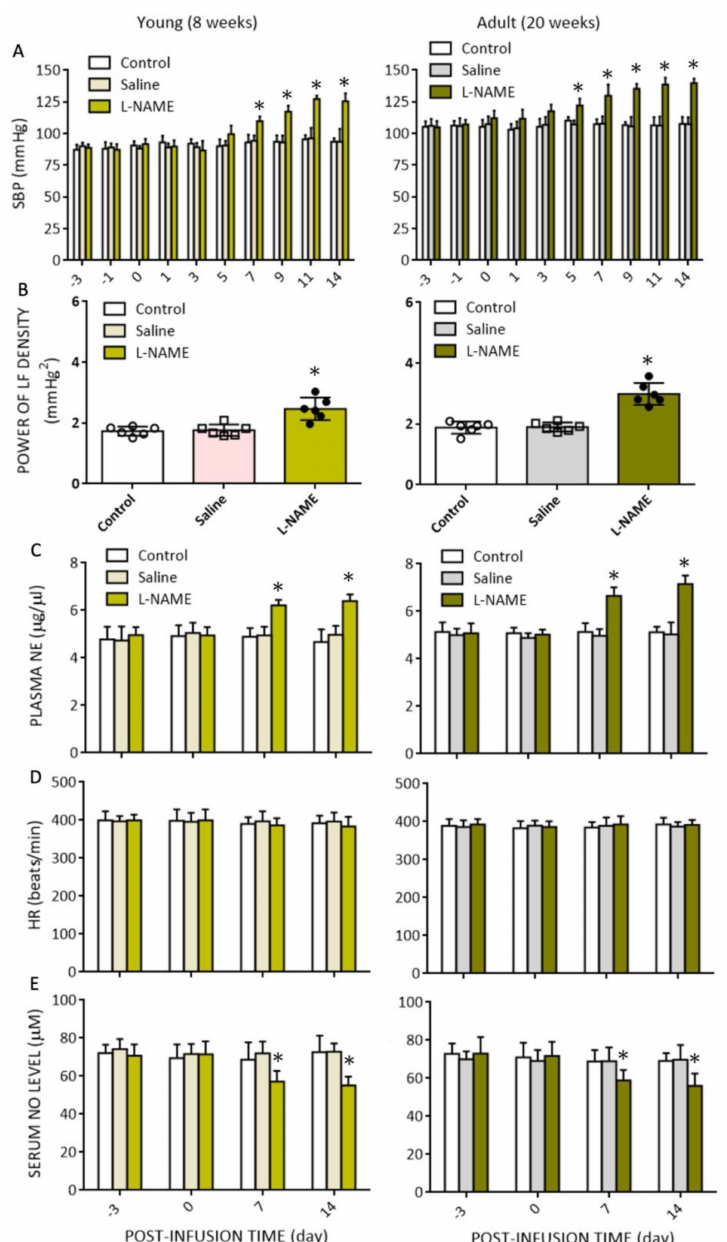
Figure 2. Temporal changes in hemodynamic parameters and serum NO (nitrite and nitrate) levels in response to intraperitoneal infusion of L -NAME (10 mg/kg/day) for 14 days. Changes in ( A ) systolic blood pressure (SBP); ( B ) power density of low-frequency (LF) component of SBP signal; ( C ) plasma norepinephrine (NE) levels; ( D ) heart rate (HR); as well as ( E ) serum NO levels detected at different time points in the untreated group, or animals treated with i.p. infusion of saline or L -NAME. Data are presented as mean ± SD, n = 6 per group at each time interval. * p < 0.05 versus saline-treated group (pink or gray bars) in post hoc Tukey’s multiple-range